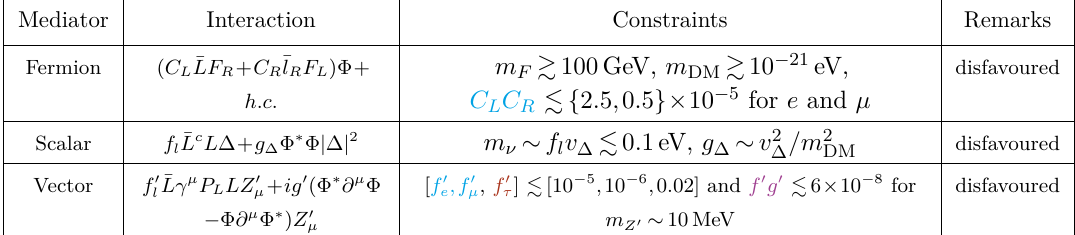
Table 2 . Summary of renormalisable neutrino-DM interactions. Colour coding is the same as in table